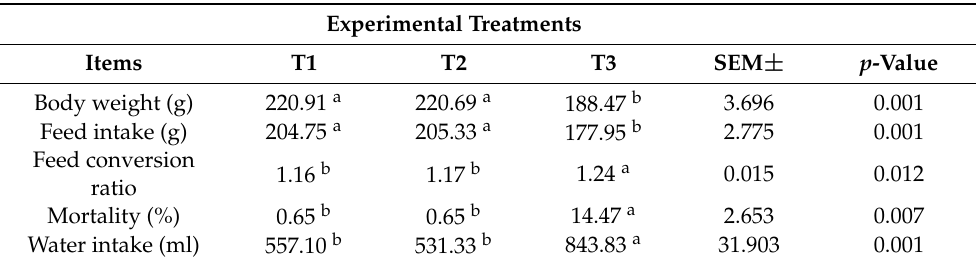
Table 3. Effect of acetic acid and sodium bicarbonate supplemented to drinking water on growth performance of young broilers (0–10 days).